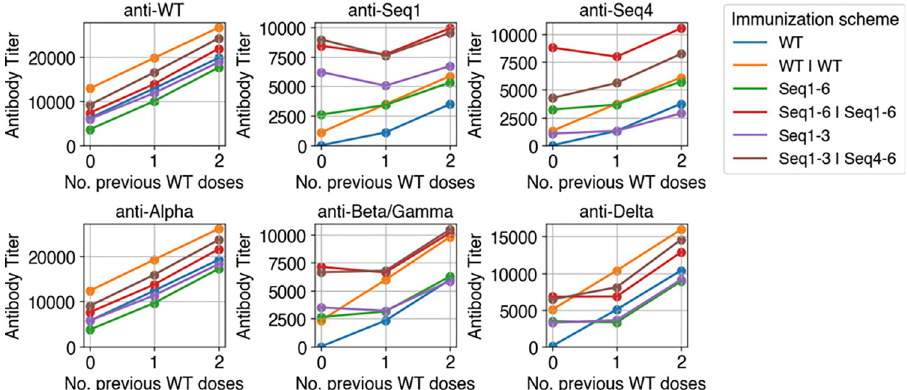
Fig 5. Titers against variants are affected by previous WT immunizations. Titers against various antigens (indicated in panel title) as a function of the number of previous WT immunizations. Sequences 2 and 3 are similar to sequence 1, so they are omitted for clarity. Sequences 5 and 6 are also omitted because they are similar to sequence 4. Beta and Gamma variants carry biochemically similar RBD mutations, so they are equivalent in this